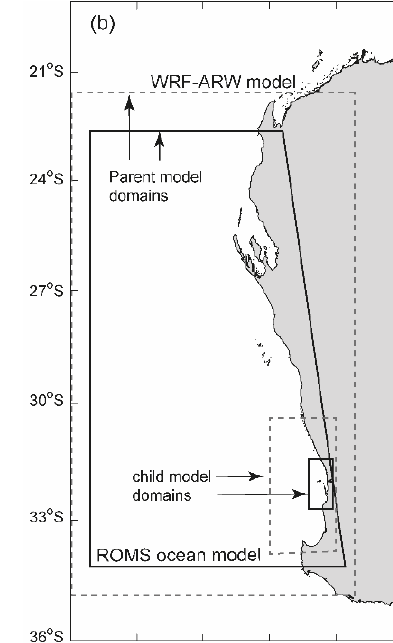
Figure 2. ( a ) Location of the study region in south-west Australia. The box identified by the dashed line shows the primary area of interest. Bathymetry is in meters; ( b ) Extent of the model grids used in the study including parent and child model domains for the WRF-ARW (dashed lines) and ROMS ocean model (solid lines).